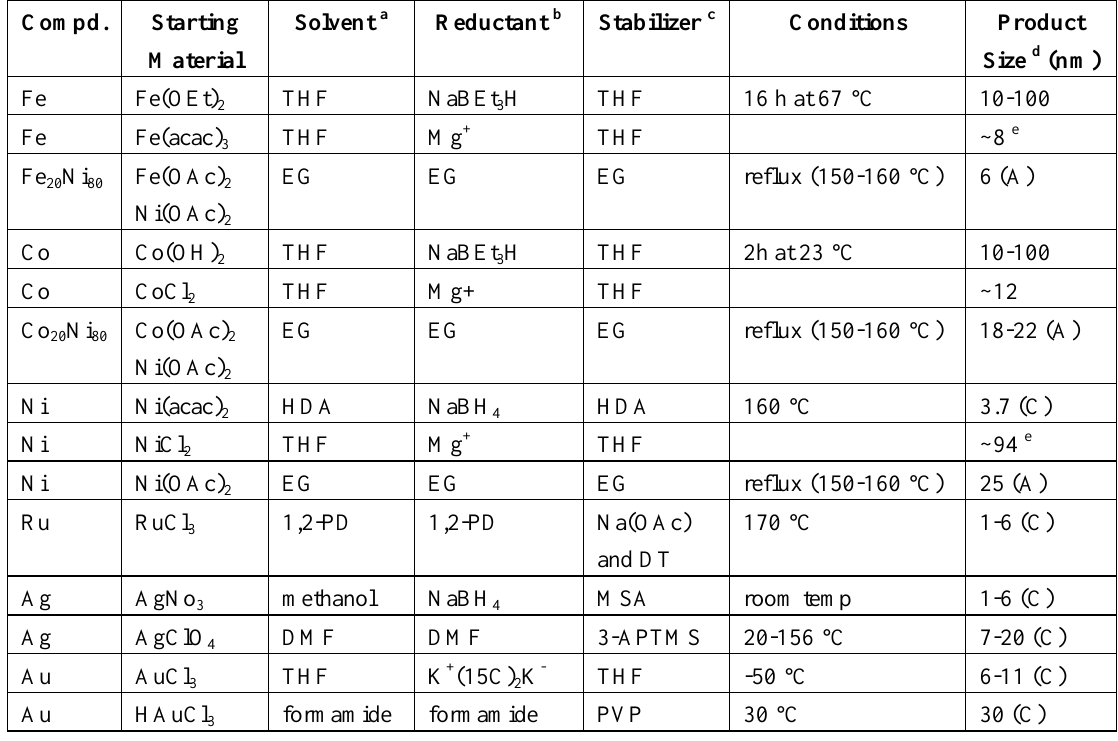
Table 2. Inorganic nanoparticles precipitated by reduction from nonaqueous solutions (adapted from